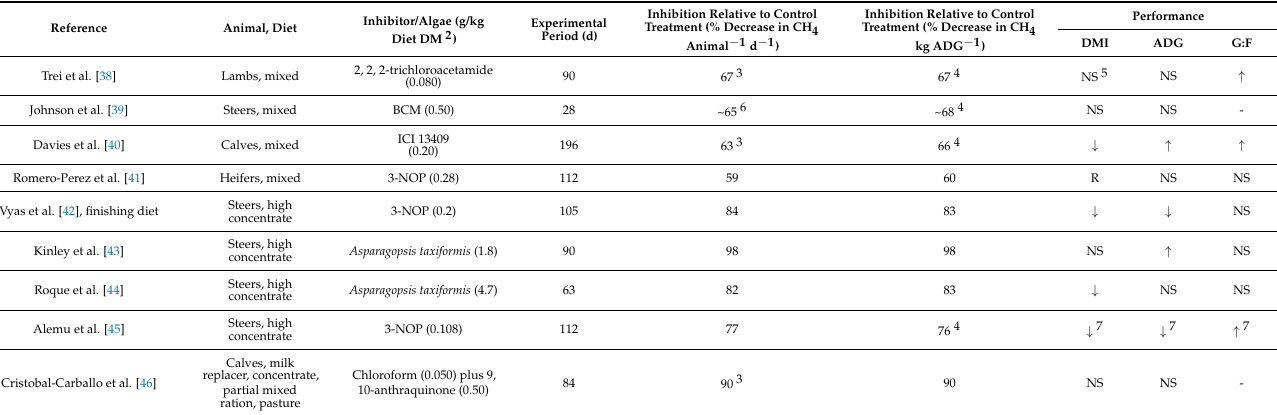
please refer to Table S1. 2 Abbreviations: 3-NOP = 3-nitrooxypropanol; ADG = average daily body mass gain; BCM = bromochloromethane; CH 4 = methane; DM = dry matter; DMI = dry matter intake; G:F = body mass gain per kilogram of dry matter intake; ICI 13409 = 2,4-bis(trichloromethy1)-benzo(1,3)dioxin-6-carboxylic acid. 3 Methane concentration, rather than production, was measured by rumenotomy [38,47] or air expelled in a hood [40]. 4 Calculated from reported results. 5 NS = effects reported as not significant ( p > 0.05); ↑ = increase ( p < 0.05); ↓ = decrease ( p < 0.05); ↑ = tendency to increase (0.05 ≤ p < 0.10); ↓ = tendency to decrease (0.05 ≤ p <